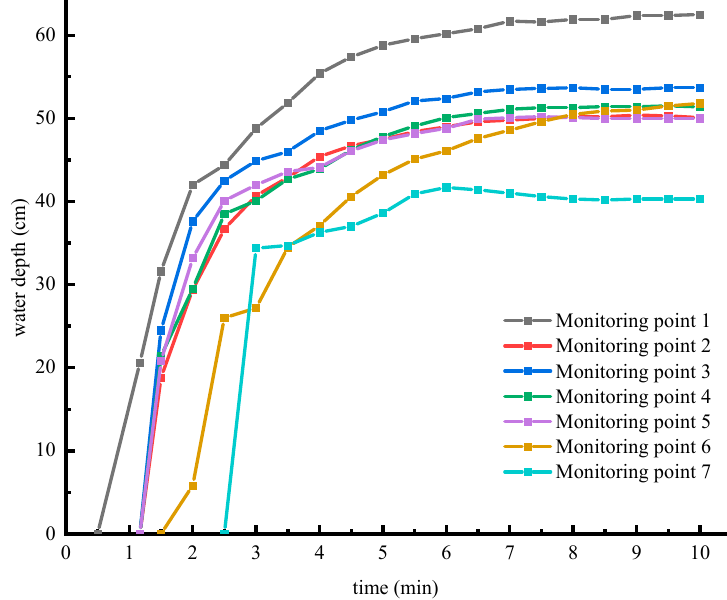
Figure 11. Water depth at monitoring points on the property development floor as a function of time. Table 1. Time required for water depth of the monitoring point to exceed 50 cm. Monitoring Point